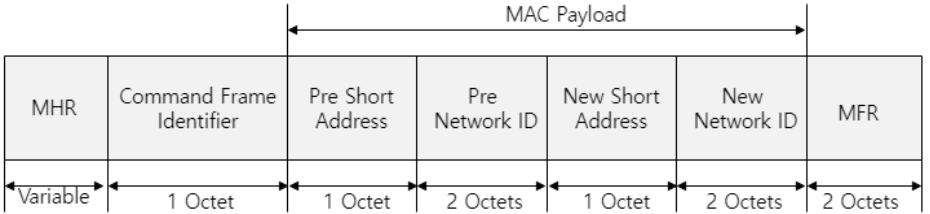
Figure 13. The proposed handover-response frame structure.